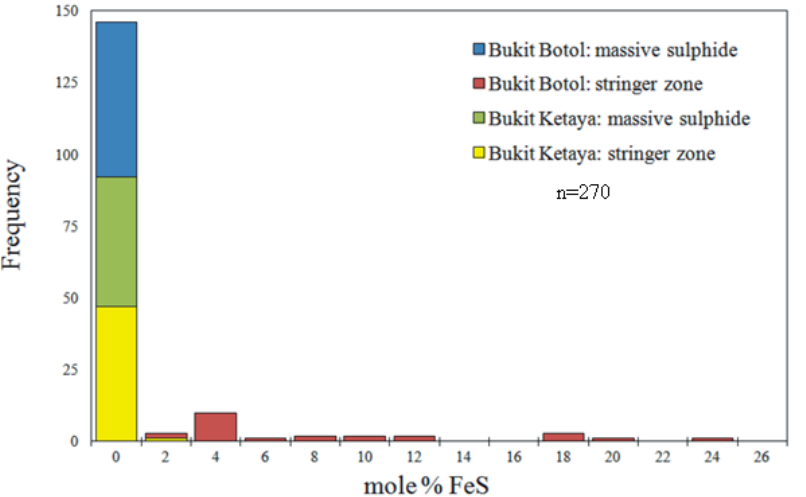
Figure 3. Frequency distribution diagram for the mole% FeS in sphalerite from the Bukit Botol and Bukit Ketaya deposits, Central Peninsular Malaysia.